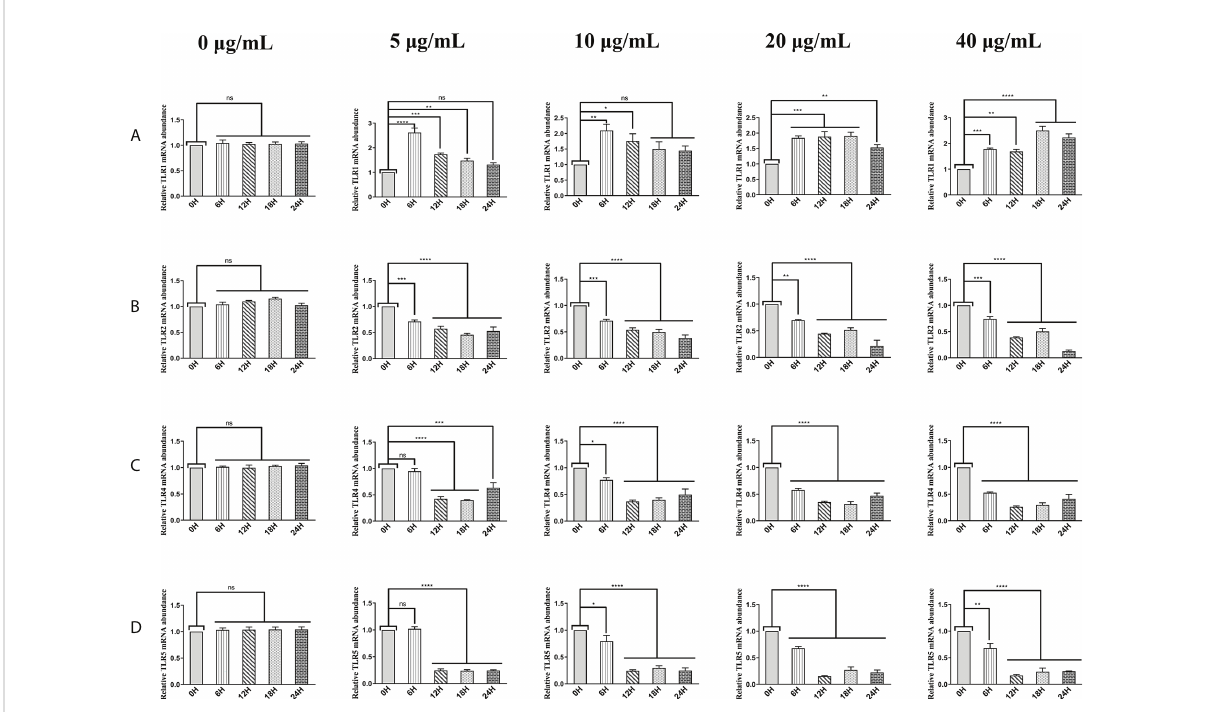
FIGURE 3 HcESPs down-regulated the transcript level of TLR2, TLR4, and TLR5 while up-regulated the transcript level of TLR1 in PBMCs. Cells were incubated with different concentrations (0, 5, 10, 20, 40 m g/mL) of HcESPs at 37°C and 5% CO 2 for 0, 6, 12, 18, and 24 hours, respectively. (A – D) : The transcript levels of TLR1, TLR2, TLR4, and TLR5 were detected by qPCR assays; Data are presented as the mean±SEM from three independent experiments. Asterisks indicate signi fi cant differences at * P <0.05, ** P <0.01, *** P <0.001, and **** P <0.0001; ns: non-signi fi